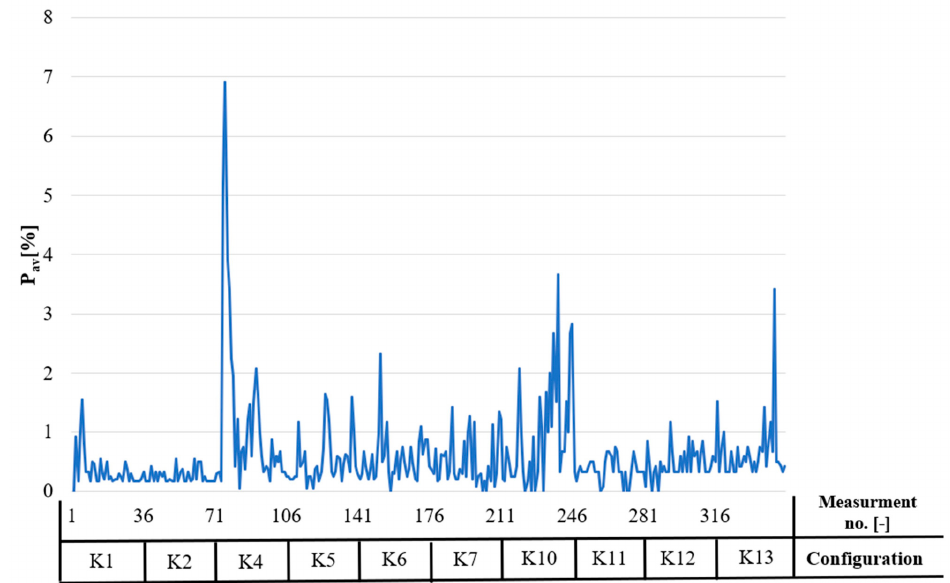
Figure 10. The number of data packets lost in each of the tests carried out (without configurations 3, 8, and 9).